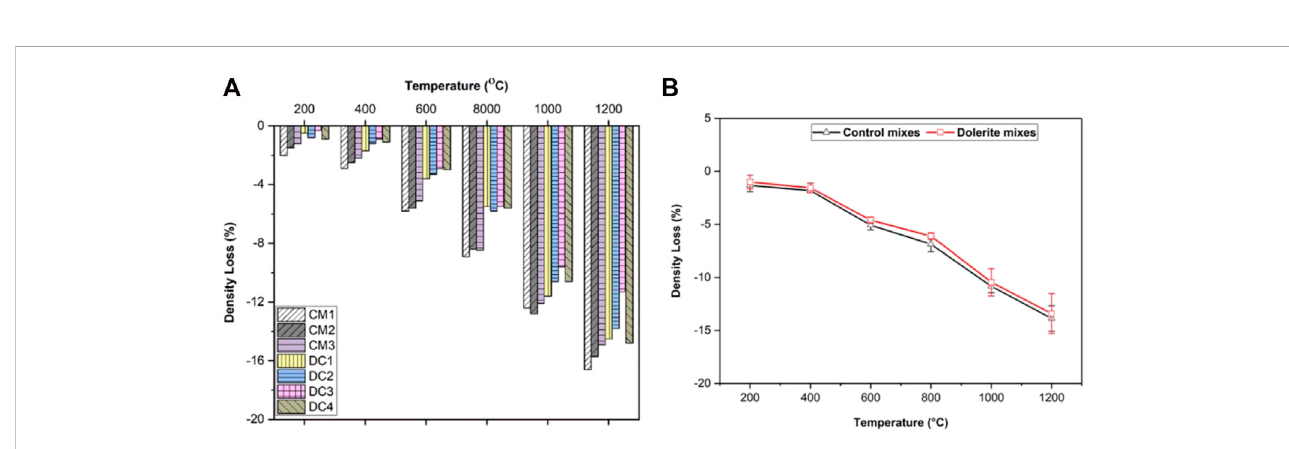
FIGURE 8 Density loss of control and dolerite mixes as function of temperature. (A) Density loss (B) mean and error bar as a function of temperature.